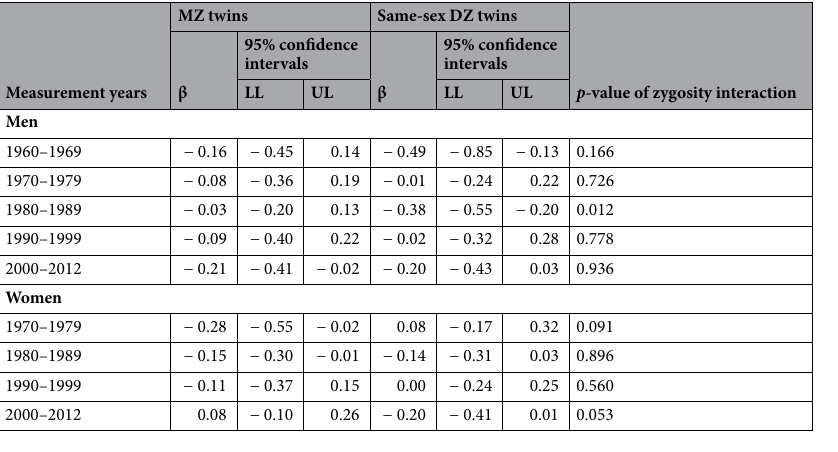
Table 4. Educational years in former smokers as compared to never smokers within discordant twin pairs by measurement year, zygosity and sex.